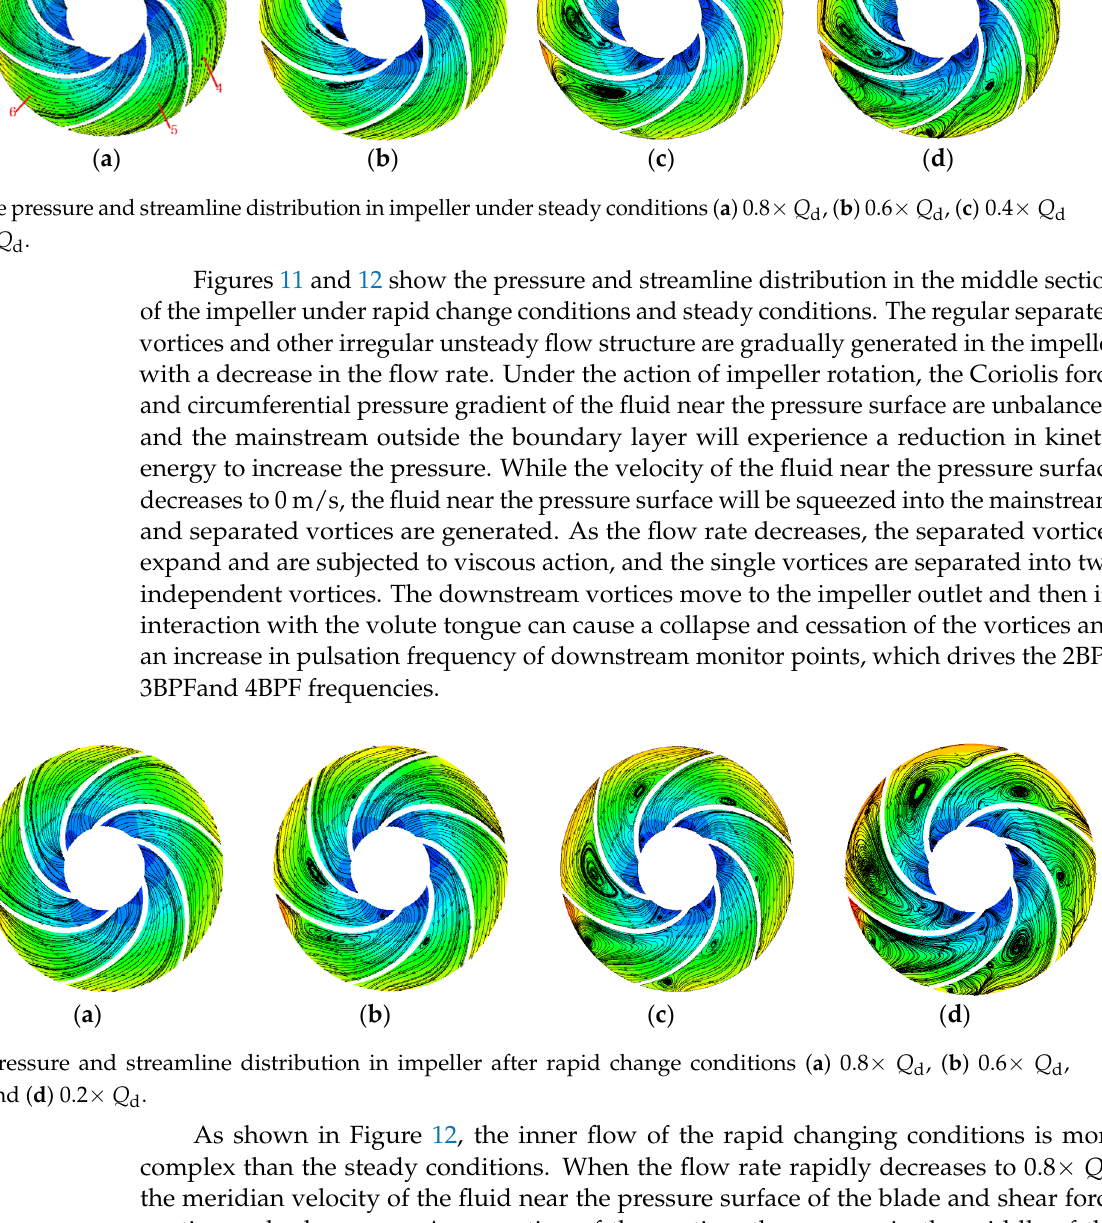
Figure 12. Pressure and streamline distribution in impeller after rapid change conditions ( a ) 0.8× Q d , ( b ) 0.6× Q d , ( c ) 0.4× Q d and ( d ) 0.2× Q d .